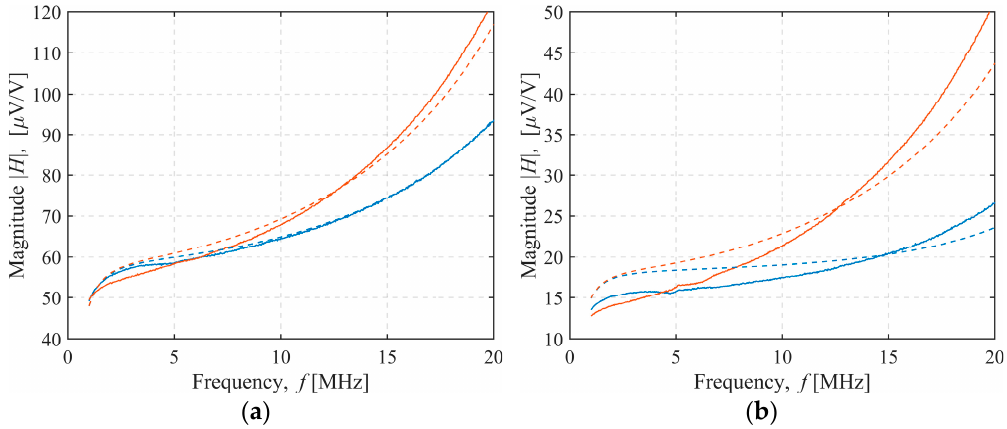
Figure 11. TX X-6/RX X-6 configuration sensor transfer function magnitude. Transmitter–receiver separation: ( a ) 27 cm, ( b ) 37 cm. Measurement (full line) and model results (dashed line). Transmitter orientation up (blue line) or down (red line).